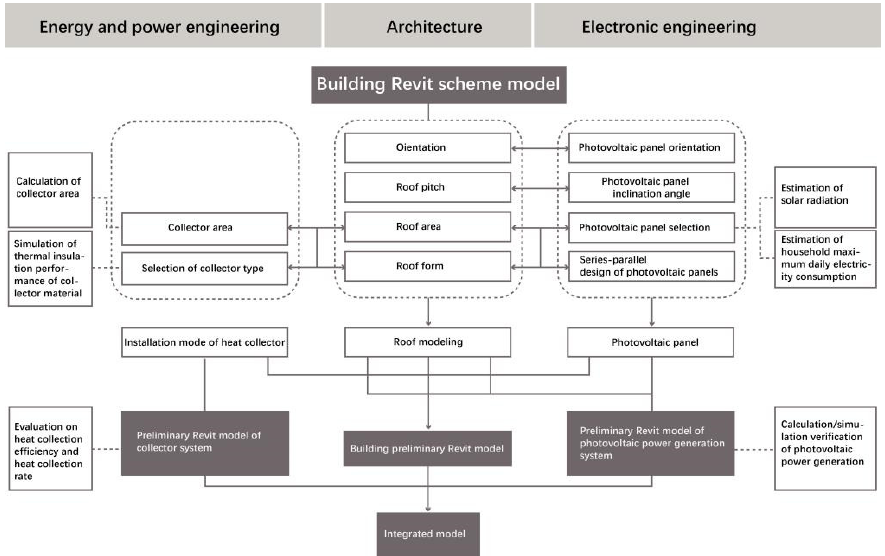
Figure 14. Collaborative design method in designing residential shape.